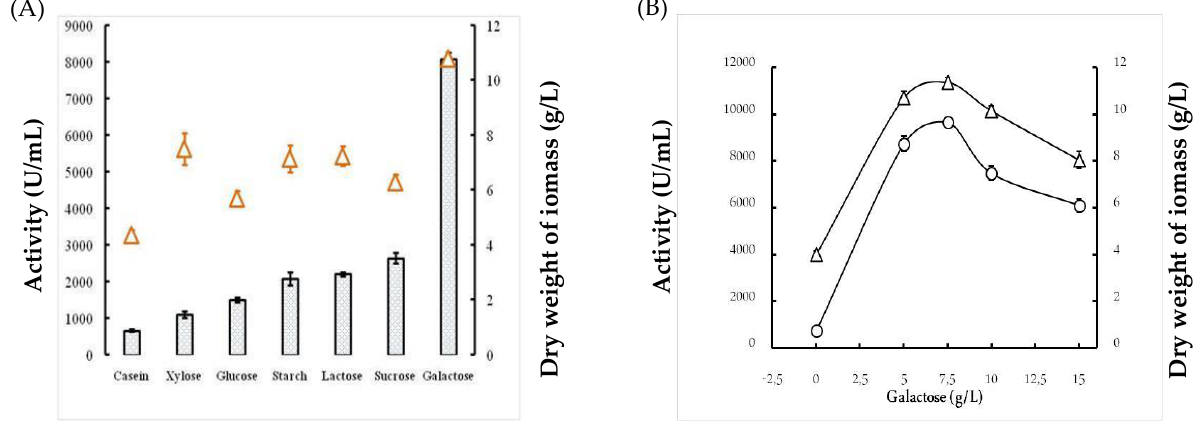
Figure 2. Effects of carbon source ( A ) and galactose concentration ( B ) on growth (triangles) and protease production (bars) from Bacillus stearothermophilus . Data are expressed as mean ( n = 3) ±